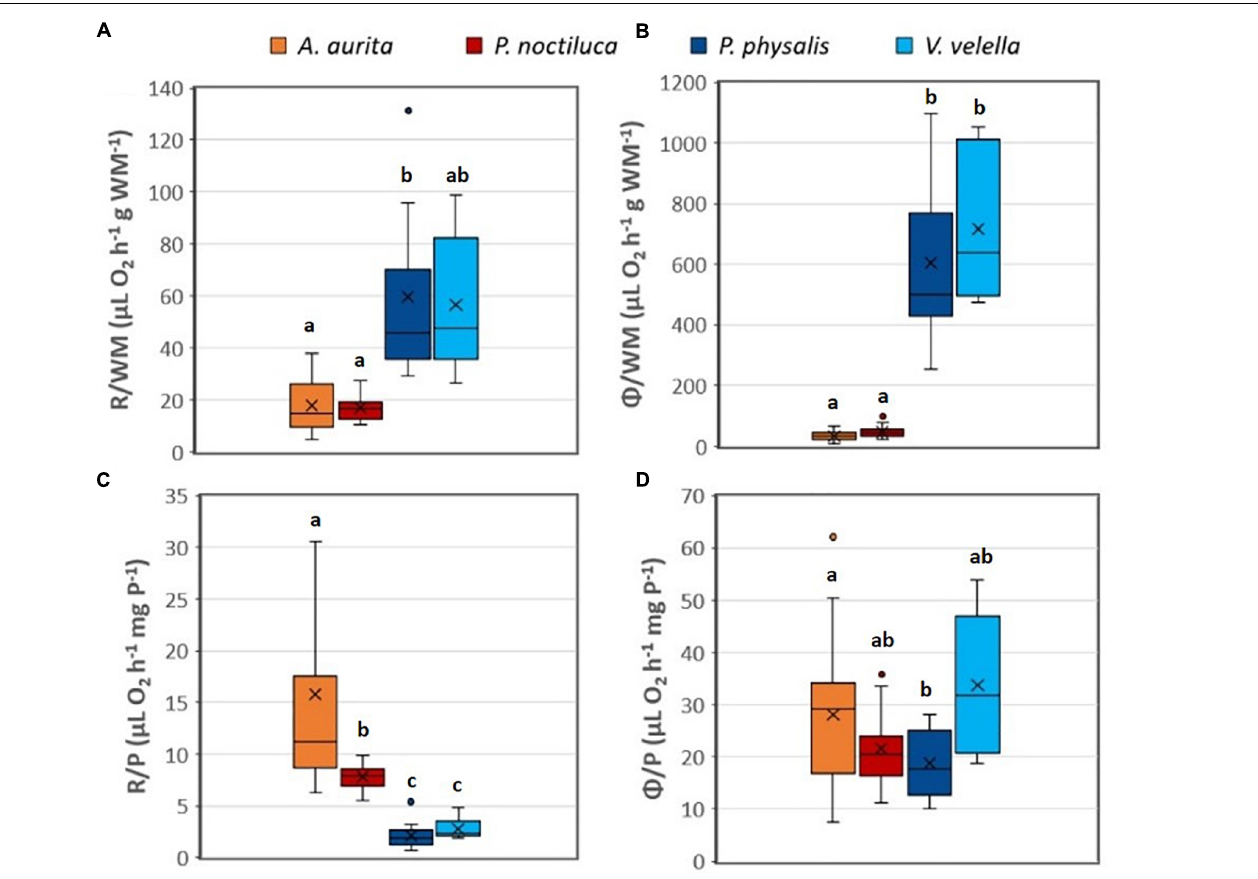
FIGURE 1 | Boxplots summarizing the results of physiological (R) and potential ( (cid:56) ) respiration normalized by wet mass (WM) (A,B) and by protein content (P) (C,D) for each species. (A,C) Are for R while (B,D) are for (cid:56) results. Small dots mark the outliers and “x,” the average. A. aurita , n = 38; P. noctiluca , n = 20; P. physalis , n = 11; V. velella , n = 5. A significant difference ( p < 0.05) in Games-Howell post hoc analysis is represented with the letters “abcd.” If the boxplots share a letter, there was no significant difference found when their data was